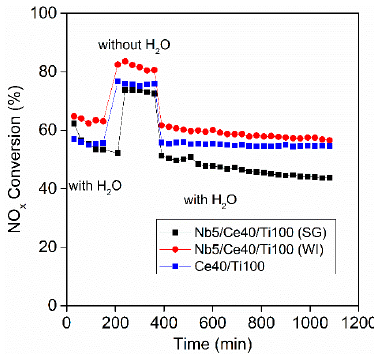
Figure 2. Long-term activity and effect of water on the SCR activity at 200 °C (1000 ppm NO x , 1000